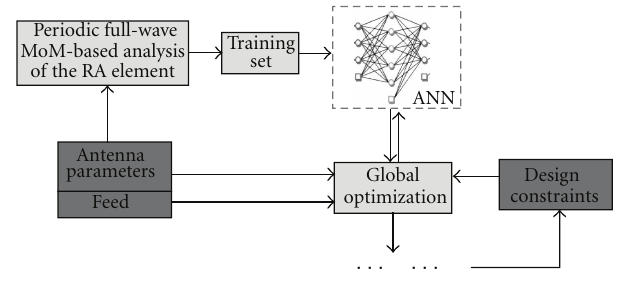
Figure 3: Part of the block diagram of Figure 1 modified by introduction of ANN.